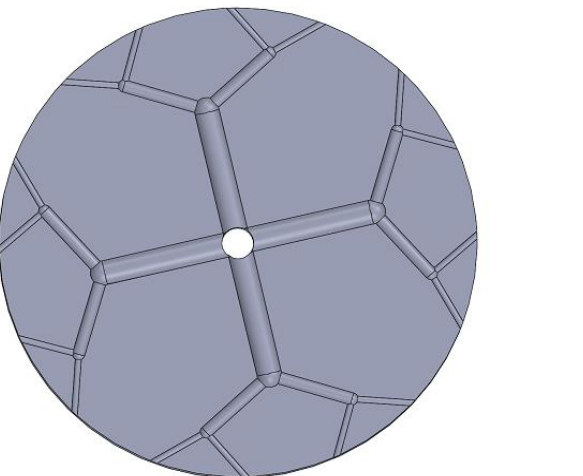
Figure 10. The improved ultra-micro DSHE-C2.